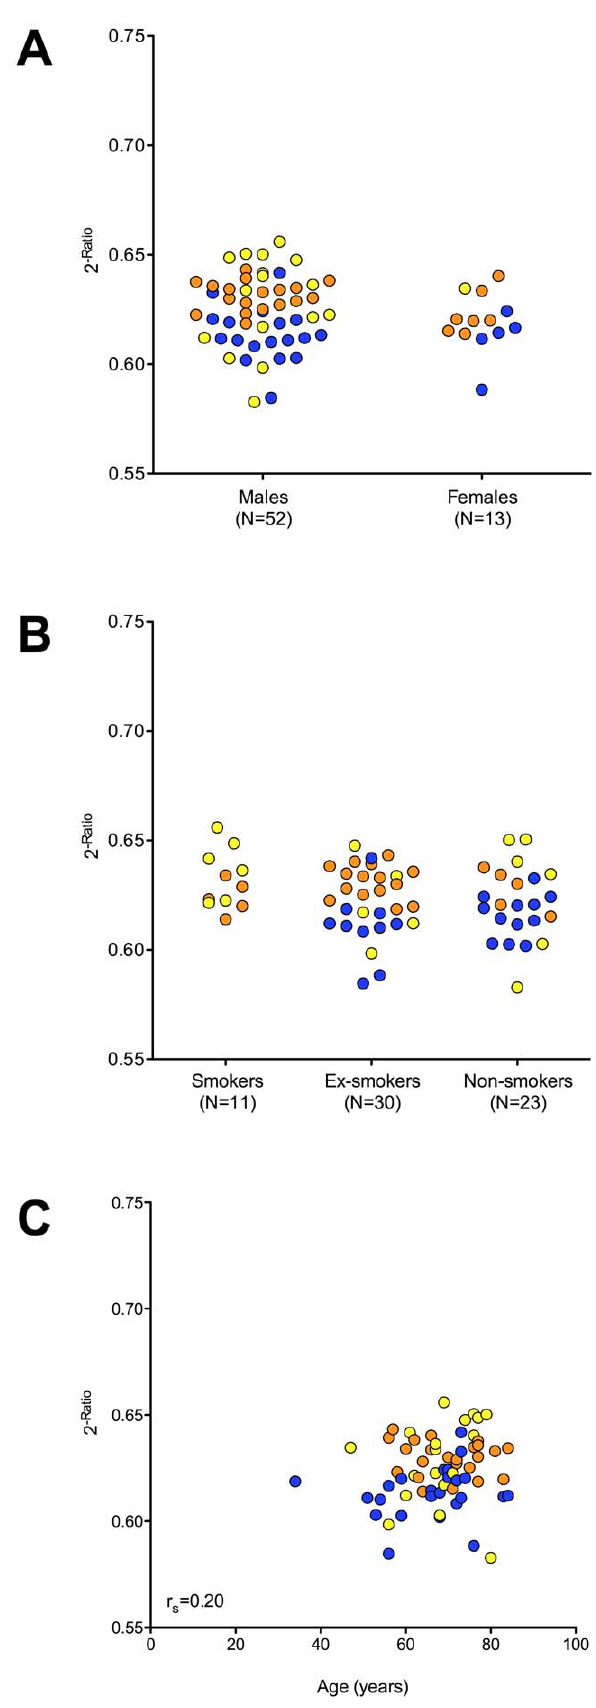
Figure 6. Scatter plots of relative expression of miR-103. Relative expression of miR-103 in the cellular fraction of human peripheral blood of malignant mesothelioma patients (blue), asbestos- exposed controls (yellow), and controls from the general population (orange) regarding (A) gender, (B) smoking status, and (C) age. The smoking status of one MMP case was not available. Expression values were normalized to miR-125a and expressed as 2 2 Ratio . Mann-Whitney tests were performed to examine differences between groups. Spearman correlation coefficient was calculated to evaluate association between miR-103 levels and